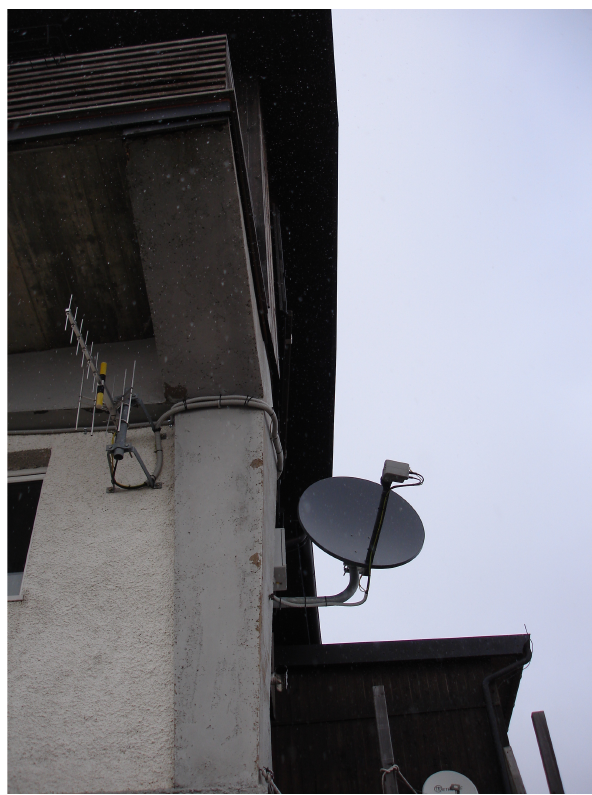
Fig. 6. Redundant data links: left UHF radio, right ASTRA connect satellite (BALD